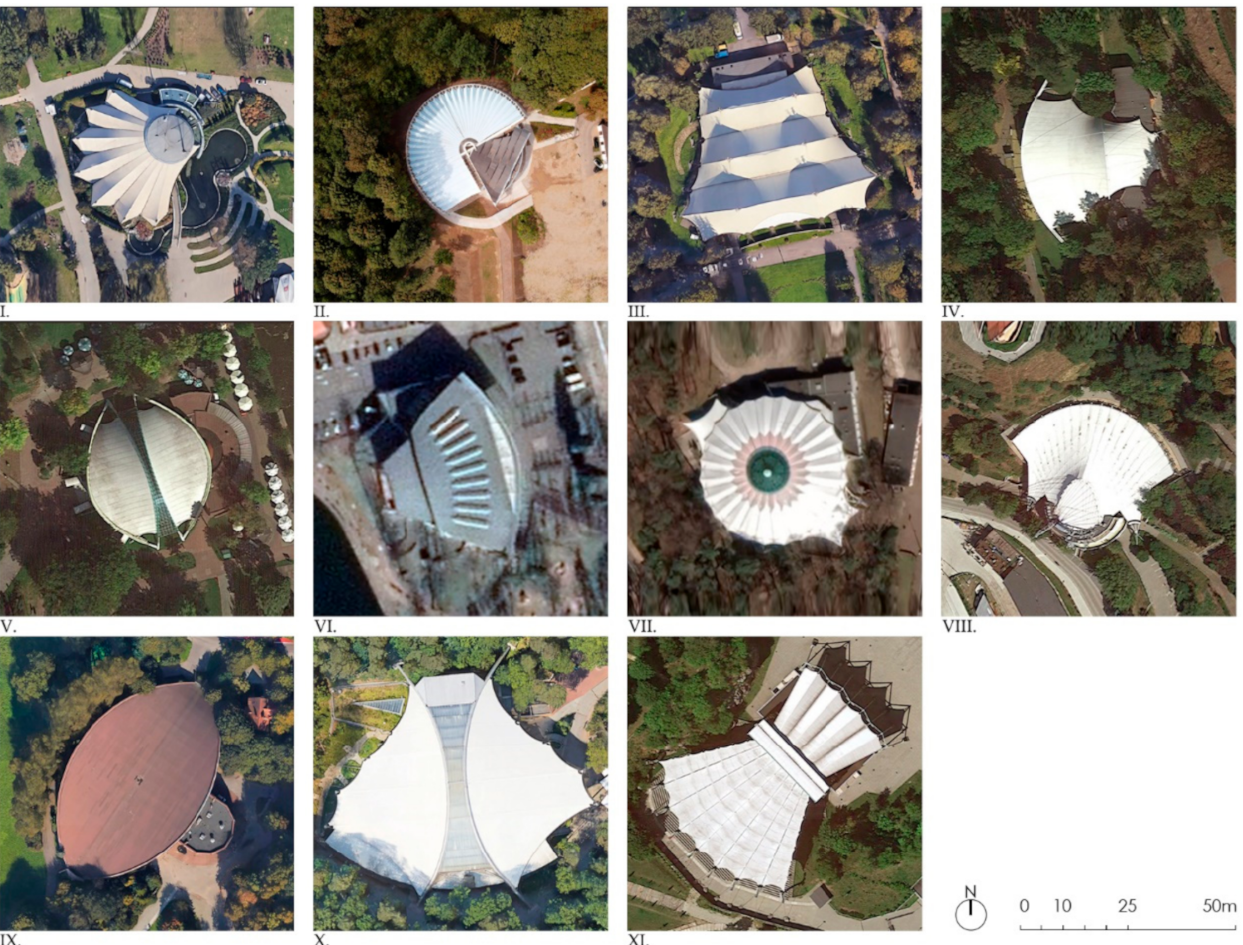
Figure 6. Form of odeons in Poland. Author’s collection based on Google Earth. All pictures are presented to the same scale, with the north direction being the top of the page. Numbers follow Table